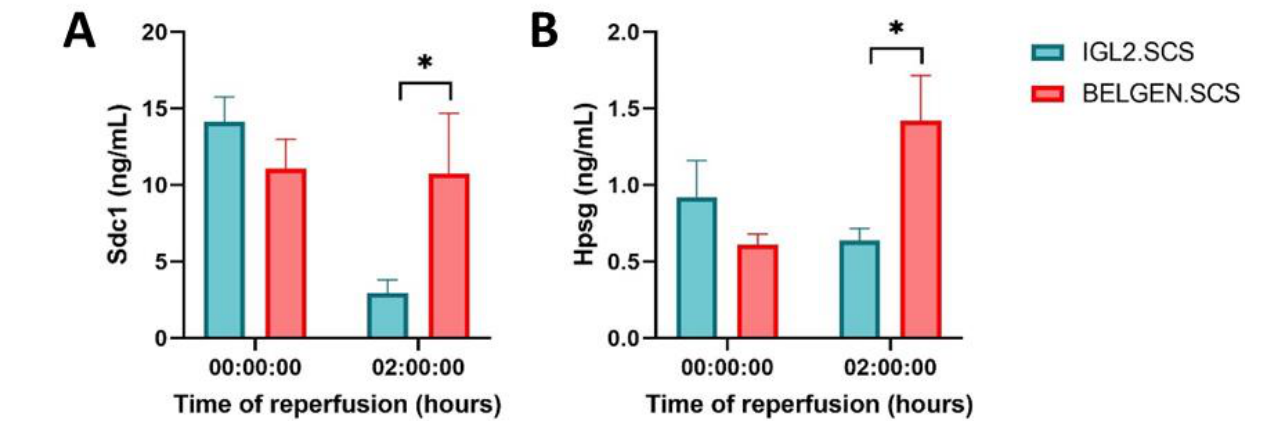
Figure 3. Glycocalyx integrity during reperfusion at 37 °C following 24 h of SCS. Proteins expression of SDC1 and HPSG by ELISA were measured from perfusates. ( A ) SDC1 levels were significantly lower after 2 h of reperfusion in the IGL2 group ( p = 0.04). ( B ) HPSG levels were significantly lower after 2 h of reperfusion in the IGL2 group ( p = 0.01). n = 6/group. * = p <0.05.